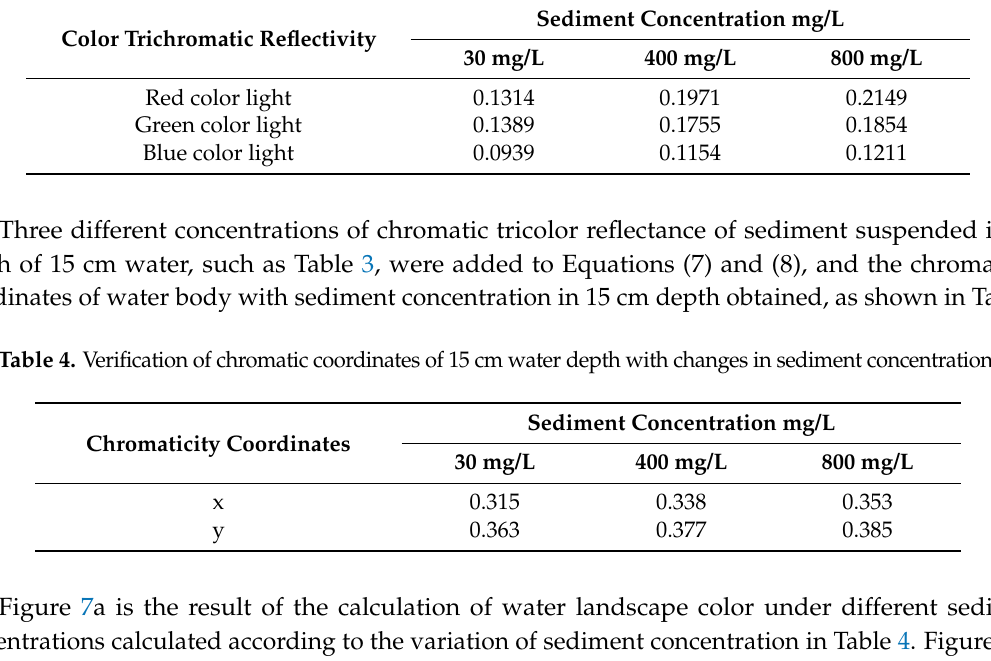
Table 3. Verification of reflectance of different concentrations of suspended sediment by trichromatic color (experimental depth 15 cm).